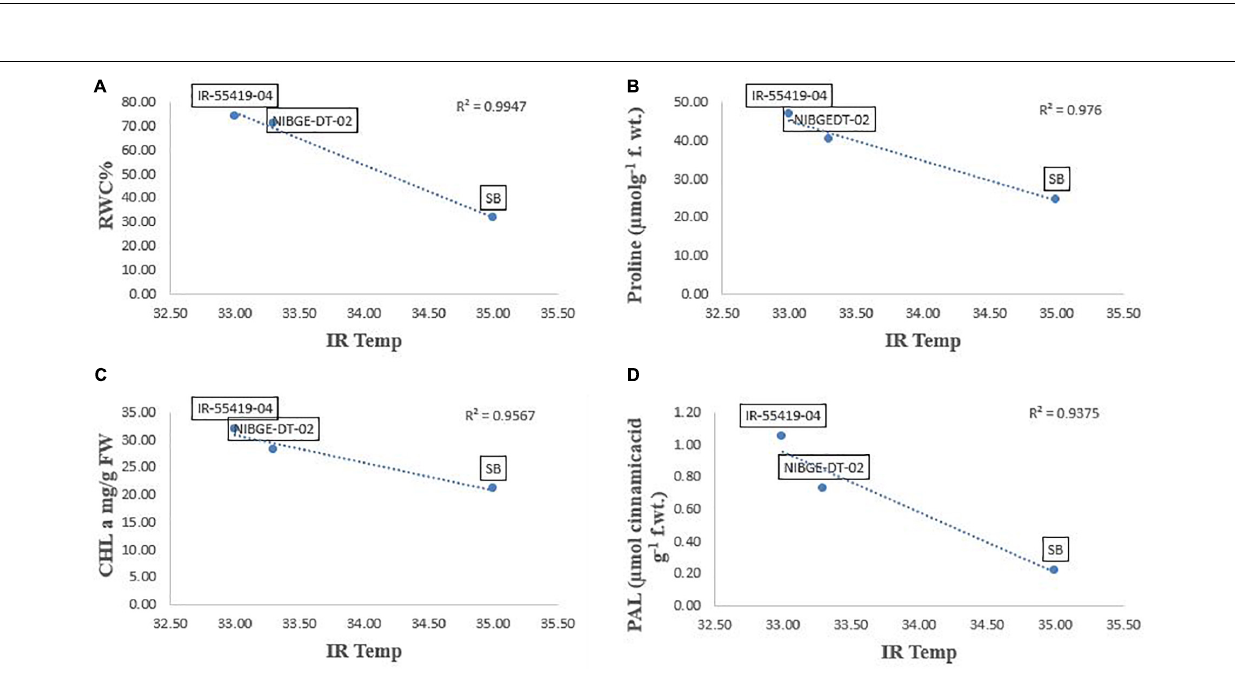
Frontiers in Plant Science |